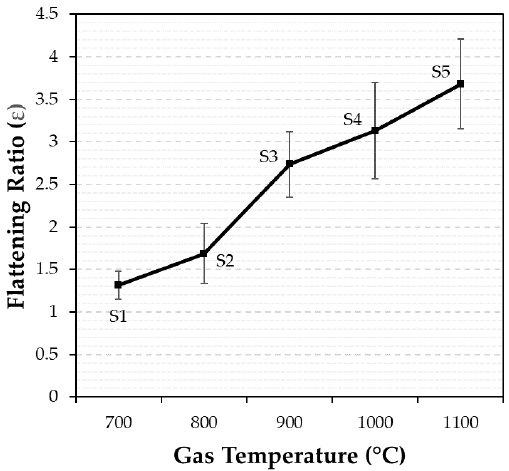
Figure 5. Evolutions of the flattening ratio, ε, of CS Zr with respect to processing temperature.